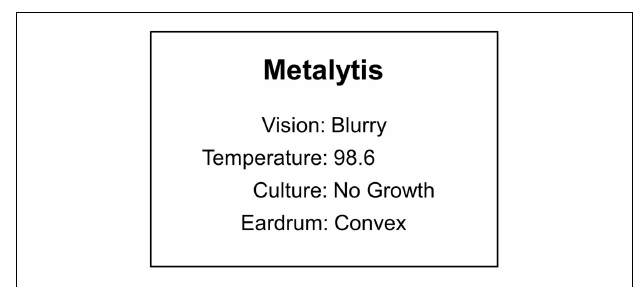
FIGURE 5 | Example exemplar used in Experiment